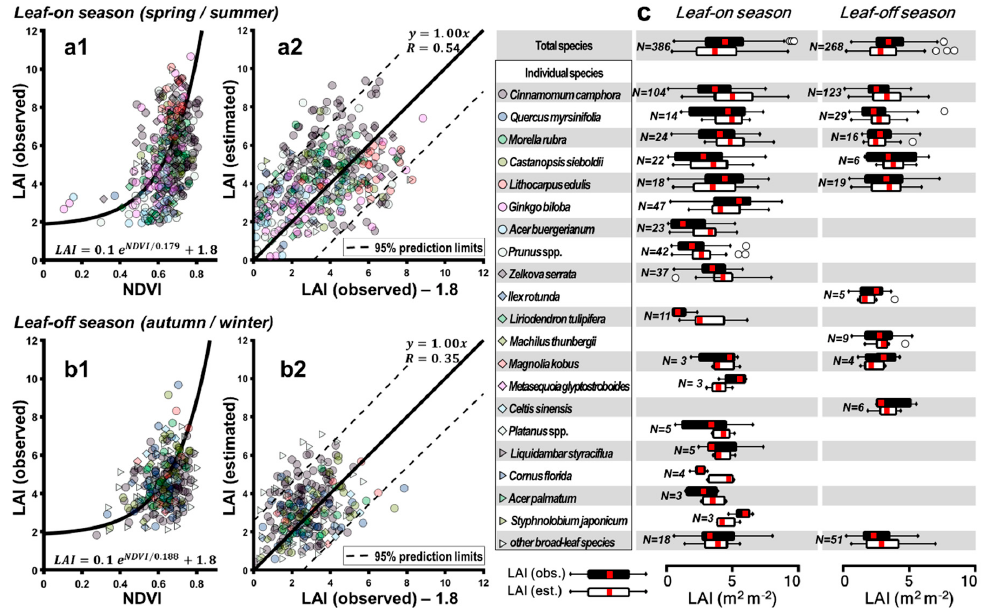
Figure 7. Performance of the LAI − NDVI (Normalized Di ff erence Vegetation Index) approximate model developed for both the leaf-on and leaf-o ff seasons. ( a1 and b1 ) Scatter plots of vegetation index (NDVI) vs. observed leaf area index (LAI; m 2 m − 2 ). The line represents the LAI − NDVI approximate model derived from the maximum NDVI and observed LAI data. ( a2 and b2 ) Estimated LAI vs. observed LAI. The y = 1.00x line is fitted. ( c ) Box plots of comparison between observed LAI and estimated LAI for each